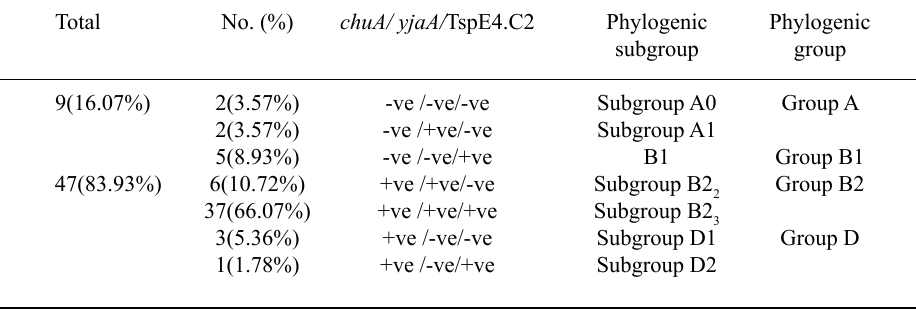
Table 2. Distribution of CRUPEC among phylogenetic